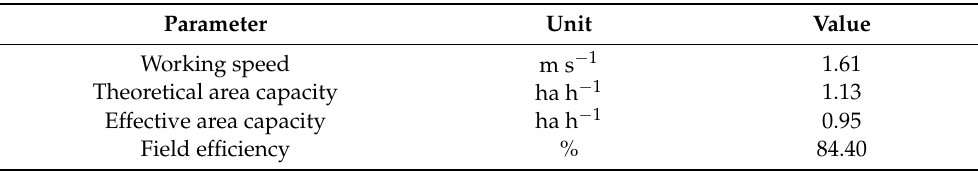
Table 1. Working times and performance of the machine. Parameter